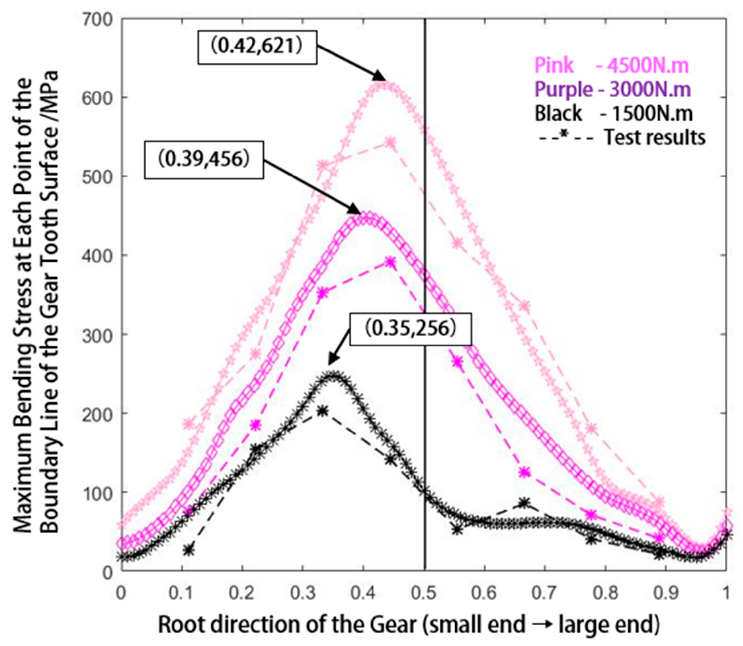
Figure 18. Results comparison of test and FEM of root bending stress of the gear.